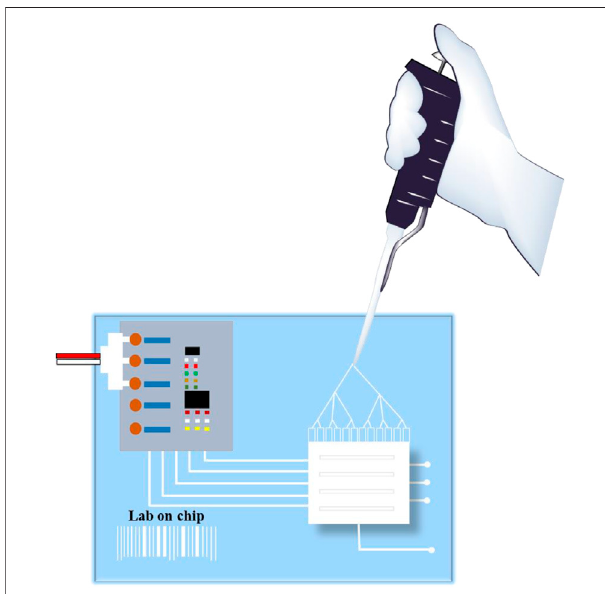
FIGURE 3 | Organ-on-a-chip using micro fl uids.